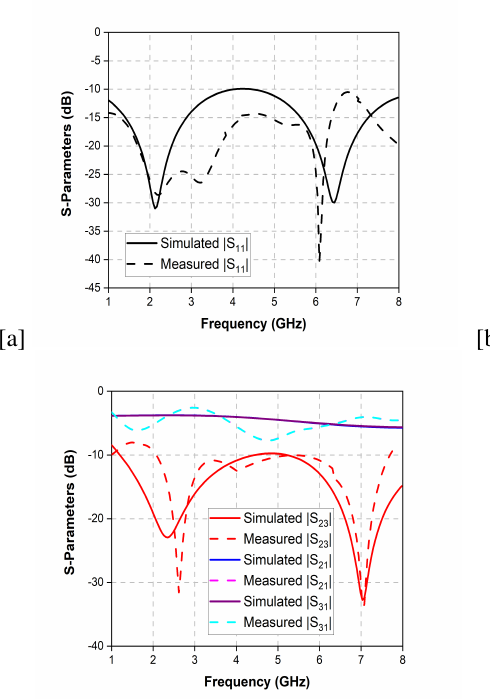
FIGURE 4. Comparison of layout simulation and measurement results of the designed circuit. (a) Input reflection (b) Isolation and Insertion loss